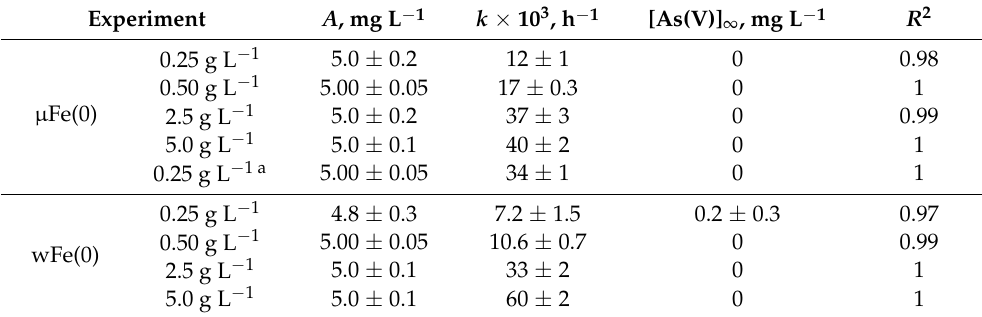
Table 1. Kinetic parameters of the experimental results of As(V) removal extracted from in Figures 1–3 with Equation (3).